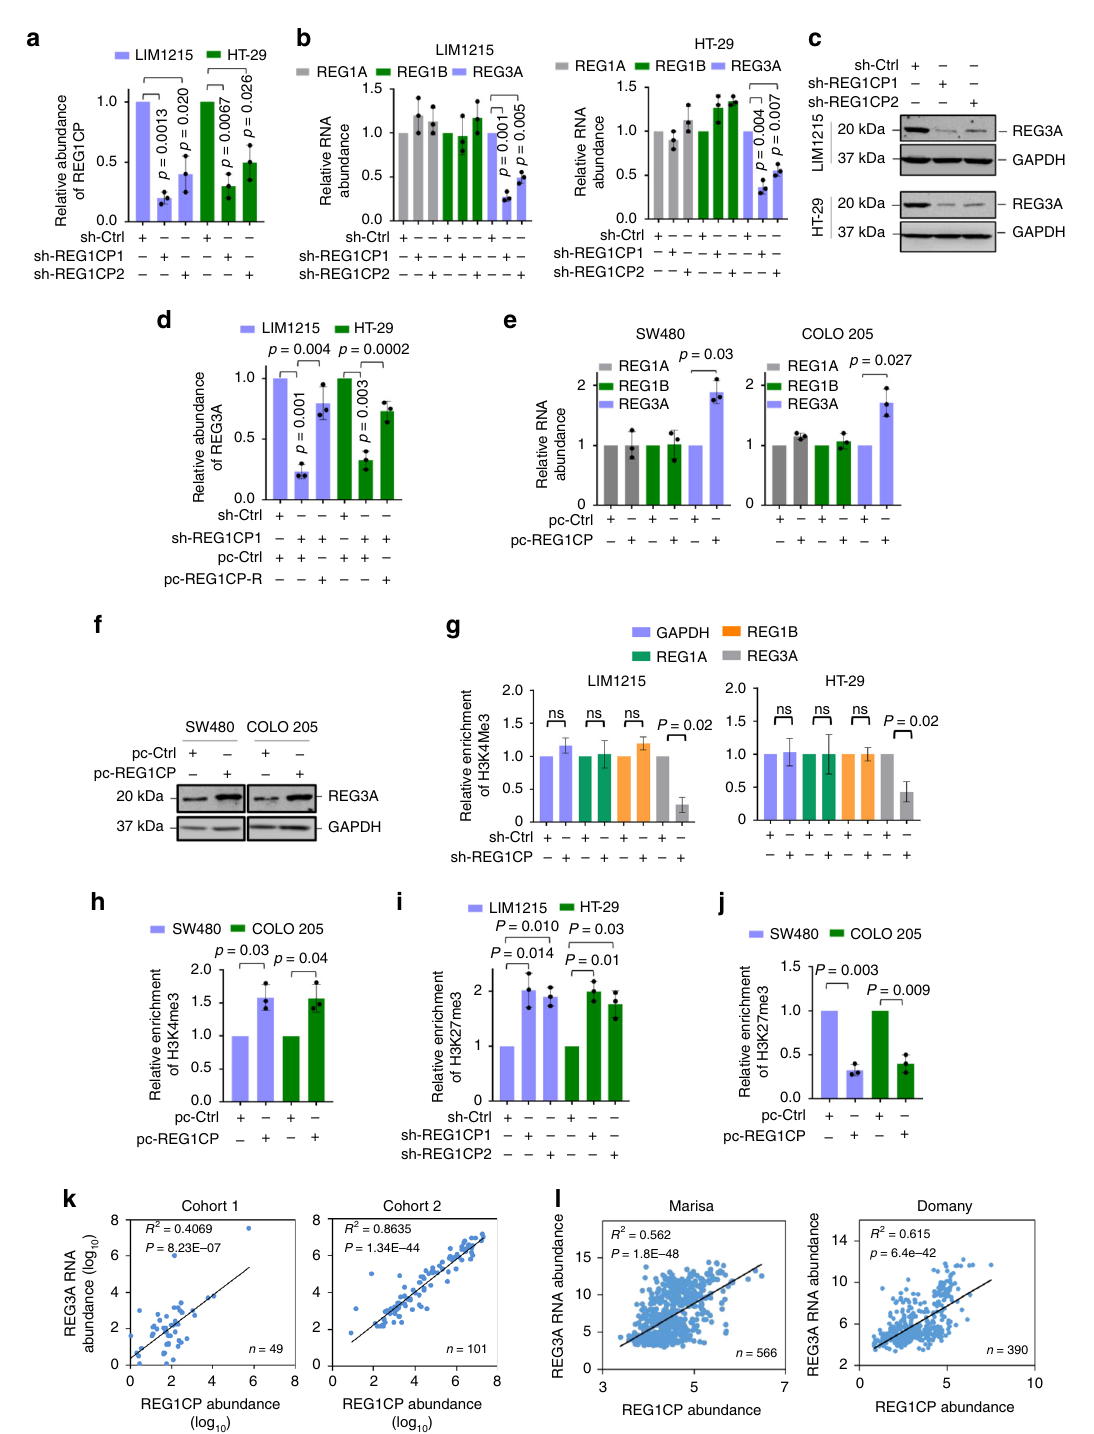
Fig. 2 REG1CP promotes transcription of REG3A . a – c Silencing of REG1CP ( a ) decreased REG3A mRNA ( b ) and protein levels ( c ). d Co-introduction of a shRNA-resistant REG1CP mutant (REG1CP-R) diminished the inhibitory effect of REG1CP silencing on REG3A mRNA expression. e , f Overexpression of REG1CP increased REG3A mRNA ( e ) and protein ( f ) levels. g , h Silencing of REG1CP decreased ( g ) whereas overexpression of REG1CP ( h ) increased enrichment of H3K4me3 to REG3A promoter, but not to REG1A or REG1B promoter ( g ). Relative enrichment of H3K4me3 to the -7/-109 fragment of REG3A promoter was measured using ChIP-qPCR assays in LIM1215 and HT-29 cells after silencing ( g ) or in SW480 and COLO205 cells after overexpression ( h ) of REG1CP. i , j Silencing of REG1CP increased ( i ) whereas overexpression of REG1CP decreased ( j ) enrichment of H3K27me3 to REG3A proximal promoter. Relative enrichment of H3K27me3 at the -7/-109 fragment of REG3A promoter was measured using ChIP-qPCR assays in LIM1215 and HT-29 cells after silencing ( i ) or in SW480 and COLO205 cells after overexpression ( j ) of REG1CP. k , l Regression analysis of the relationship between REG3A mRNA and REG1CP expression in two cohorts of colon cancer samples determined using qPCR ( k ) and in published datasets acquired from the R2 Genomics Analysis and Visualization Platform ( l ). n = 3 independent experiments unless speci fi ed differently. Data are presented as Mean ± SEM ( a , b , d , e , g – j ) or representatives ( c , f ). Statistical signi fi cance was calculated using a two-tailed t -test unless speci fi